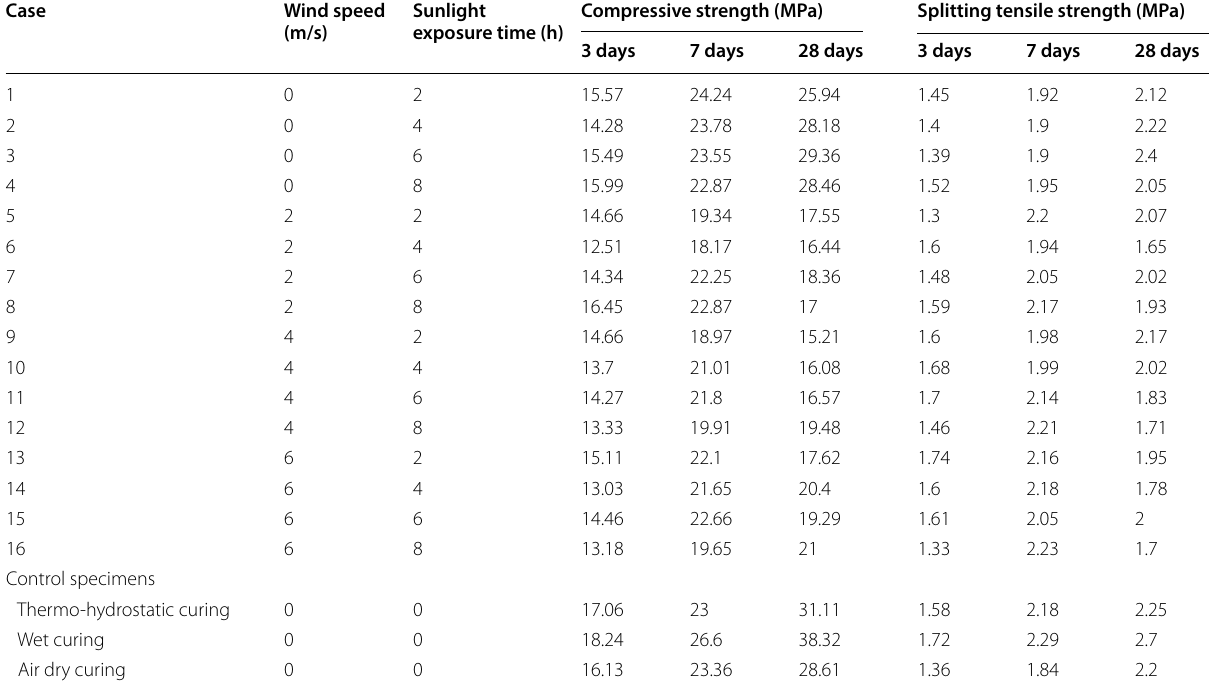
Table 4 Strength test results of wind speed–sunlight exposure time (Kim et al.